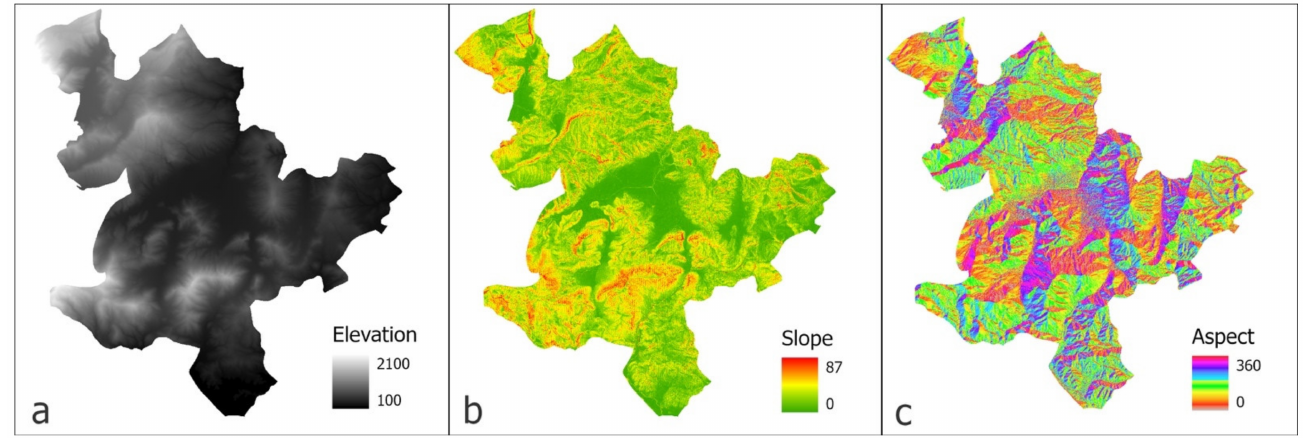
Figure 5. Topographic parameters ( a ) DEM (m), ( b ) slope (degrees), and ( c ) aspect